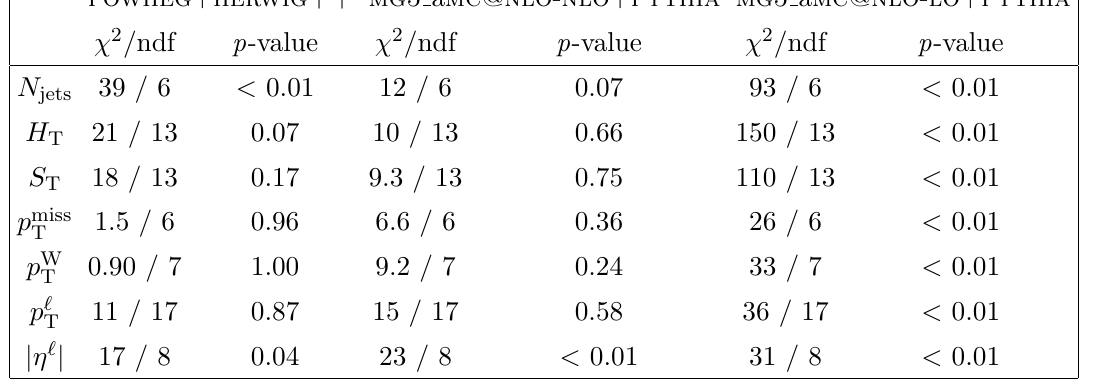
Table 3 . Results of a goodness-of-(cid:12)t test between the absolute cross sections in data and several models, with values given as (cid:31) 2 /number of degrees of freedom